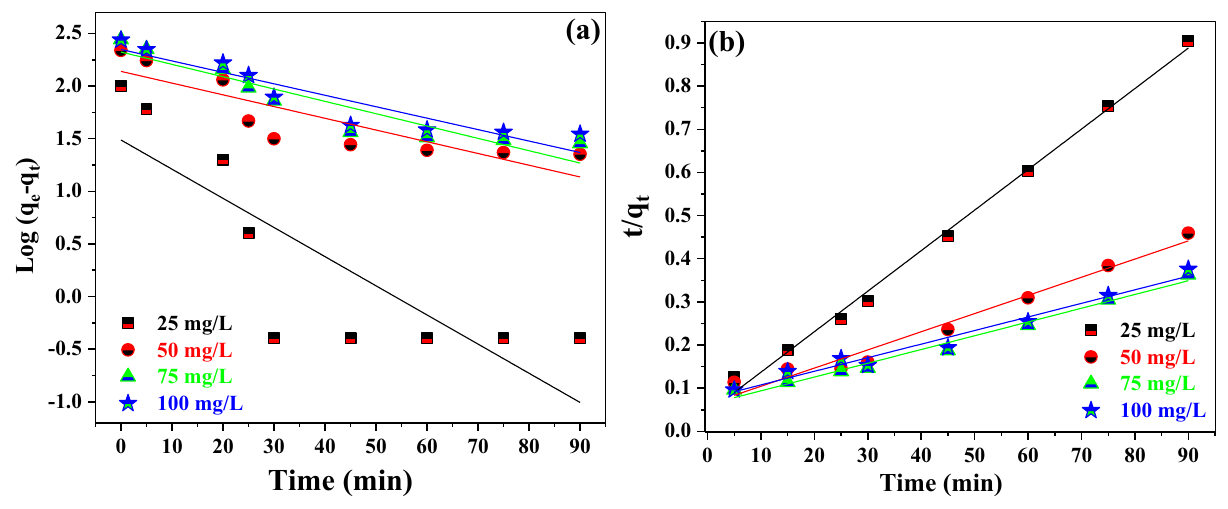
Fig. 4 Chart of quasi-first degree ( a ) and quasi-second degree ( b ) kinetic model for red cation adsorption 14 Table 3 Calculated variables for the kinetic